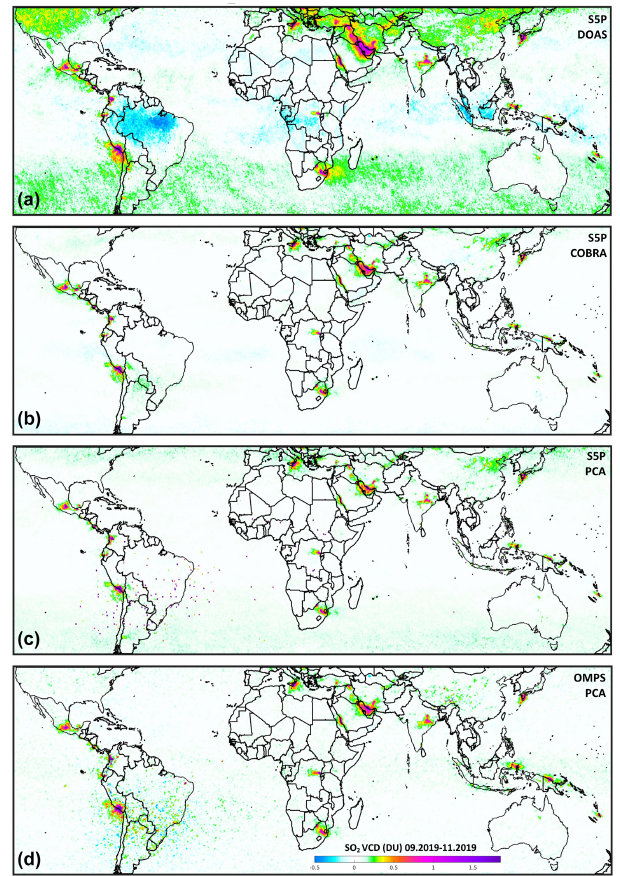
Figure 2. Comparison of seasonal mean SO 2 columns for Septem- ber to November 2019 retrieved from TROPOMI DOAS, COBRA, PCA and OMPS PCA algorithms (from top to bottom). Consistent pixel selection criteria, gridding and retrieval settings are applied (see text). For all four data sets, a fixed AMF of 0.4 is